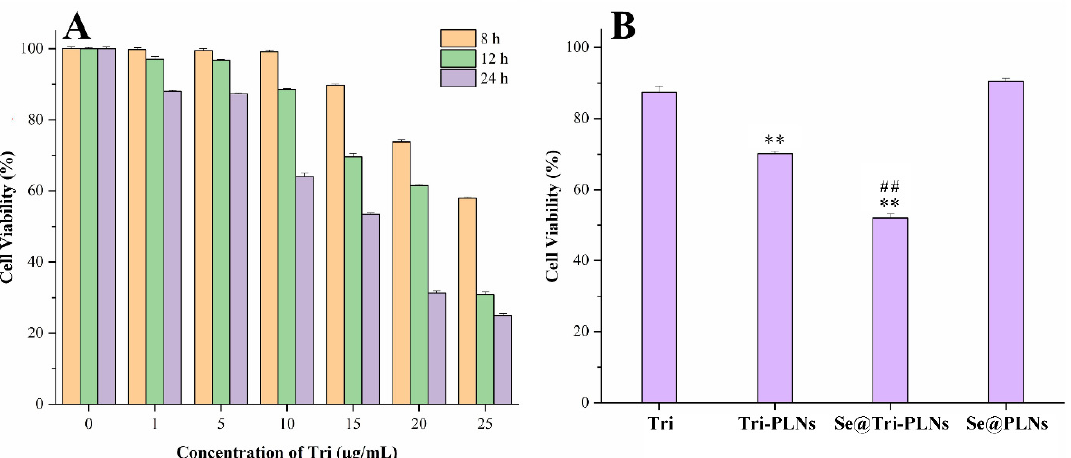
Figure 6. Cell viability analysis of free and formulated Tri: ( A ) cell viability after incubation with different concentrations of free Tri for 8 h, 12 h and 24 h; ( B ) cell viability of formulated Tri (Tri ‐ PLNs and Se@Tri ‐ PLNs) for 24 h at a concentration of 5 μ g/mL with free Tri and blank nanoparticles (Se@PLNs) as references. Data expressed as mean ± SD ( n = 6), ANOVA, ** p < 0.01, compared with Tri, ## p < 0.01, compared with Tri ‐ PLNs.